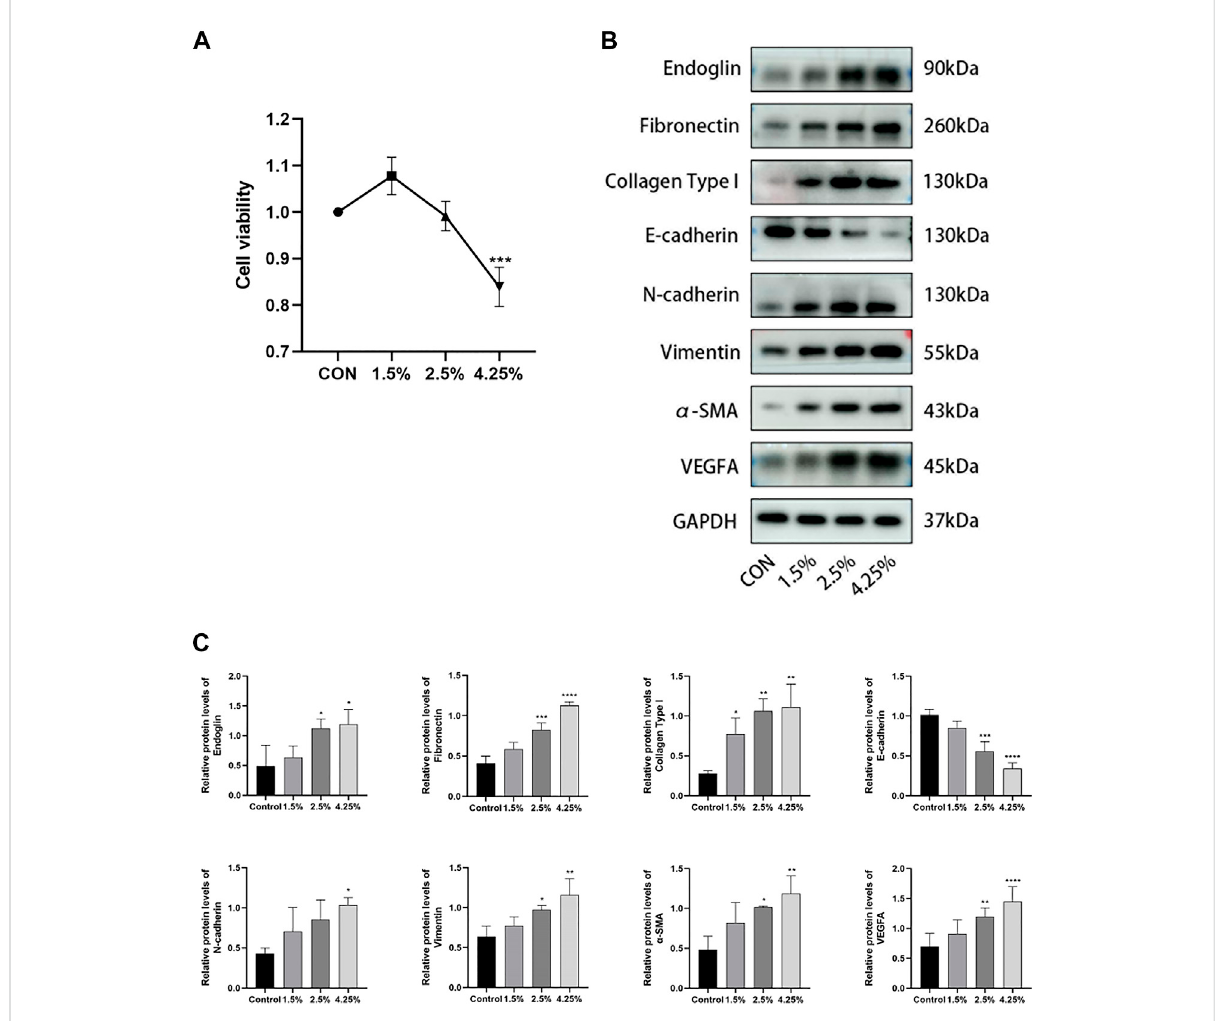
FIGURE 5 EndoglinwasupregulatedinHGstimulatedHPMCs. (A) HPMCsweretreatedwithdifferentconcentrationsofHG(control,1.5%,2.5%,4.25%)for 24 h, and CCK8 were performed to detect theviabilityof HPMCs. (Data are shown as mean ± SD,*** p < 0.001 comparedwith thecontrol, n = 3). (B) Western blot detection of endoglin, Fibronectin, Collagen Type I, E-cadherin, N-cadherin, vimentin, α -SMA and VEGFA of peritoneum in different groups. GAPDH was used as a loading control. The results from the quantitative analysis are shown in (C) . (Data are shown as mean ± SD, * p < 0.05 compared with the control, ** p < 0.01 compared with the control, *** p < 0.001 compared with the control, **** p < 0.0001 compared with the